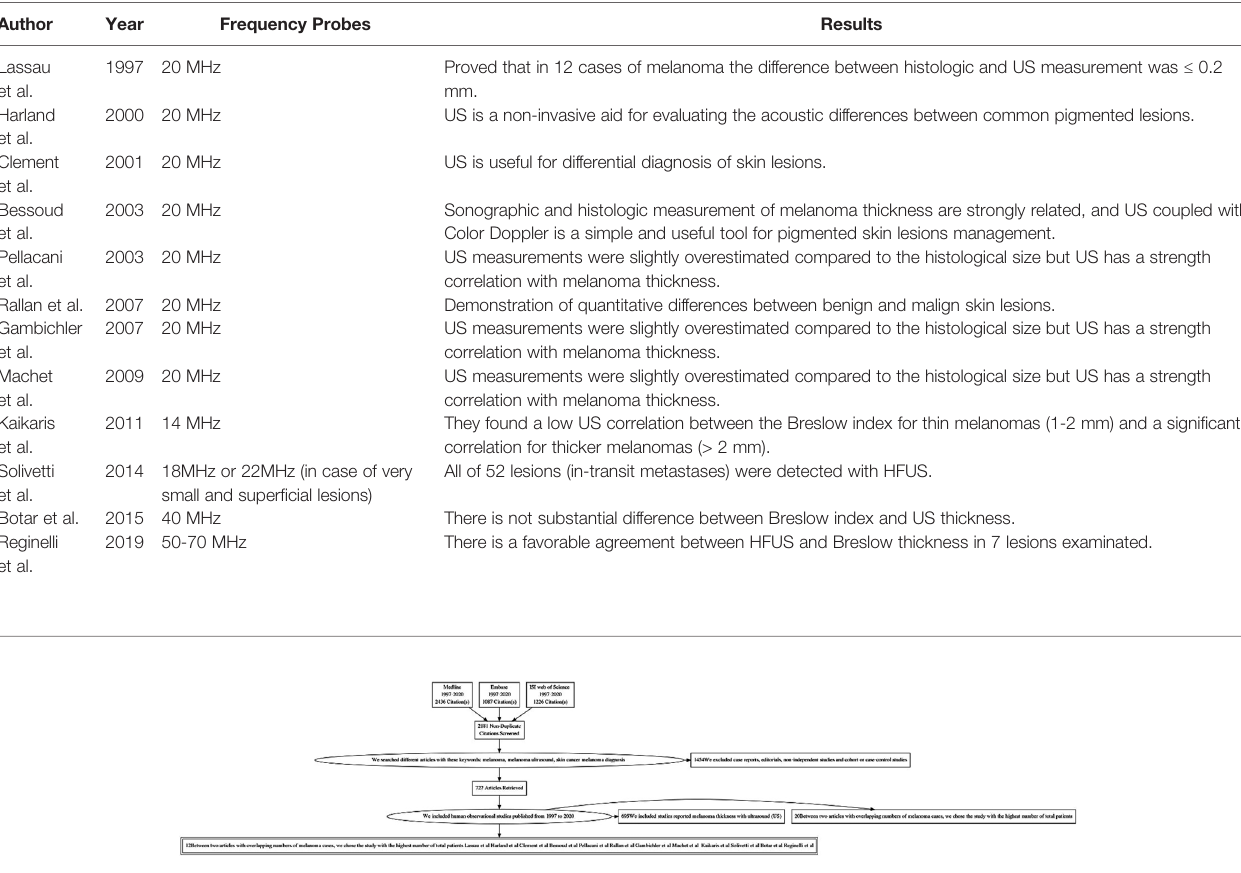
TABLE 1 | List of the main studies related to the use of the HFUS in melanoma.